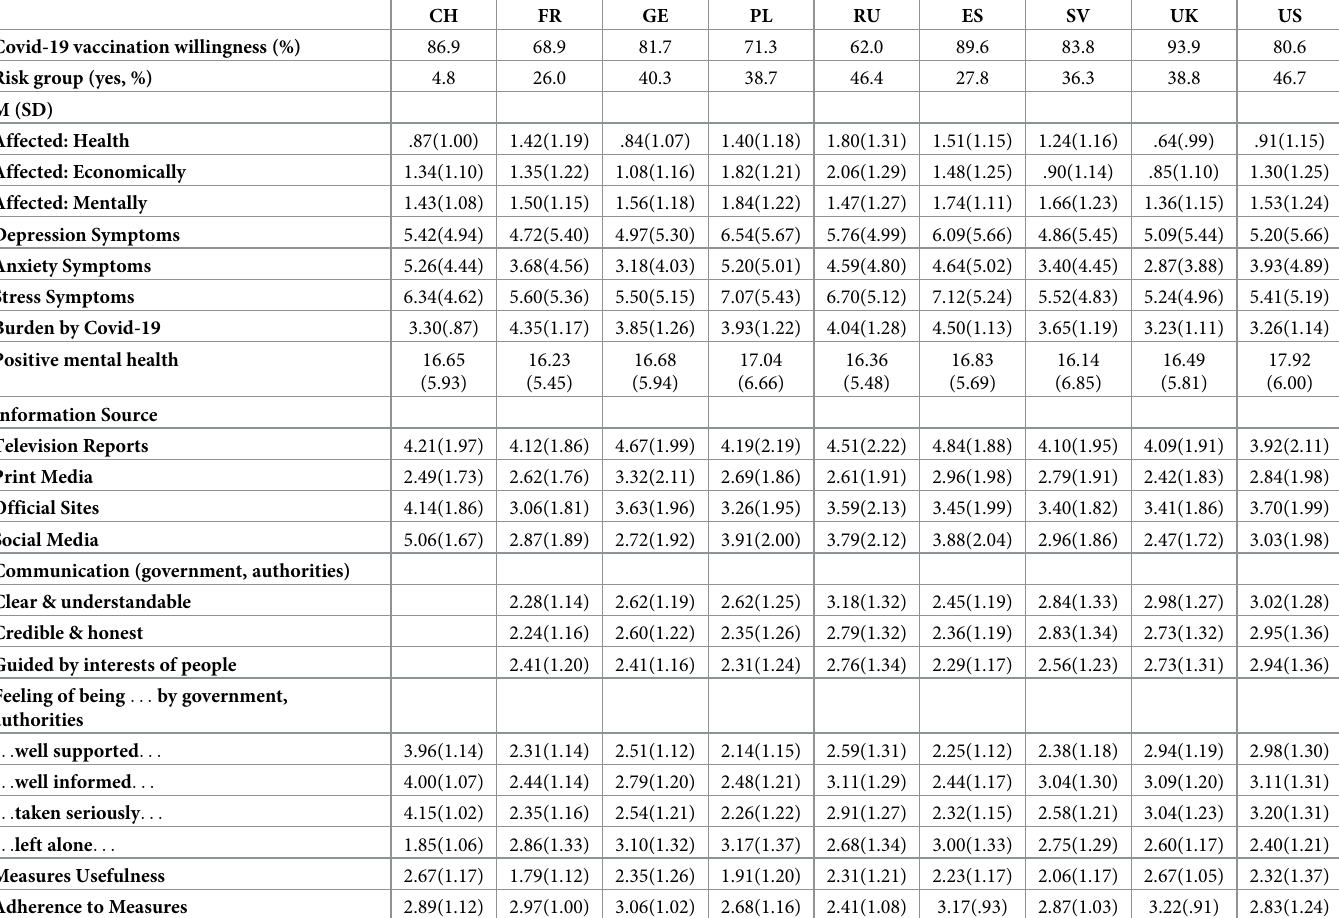
Table 2. Country-specific descriptive statistics of the investigated